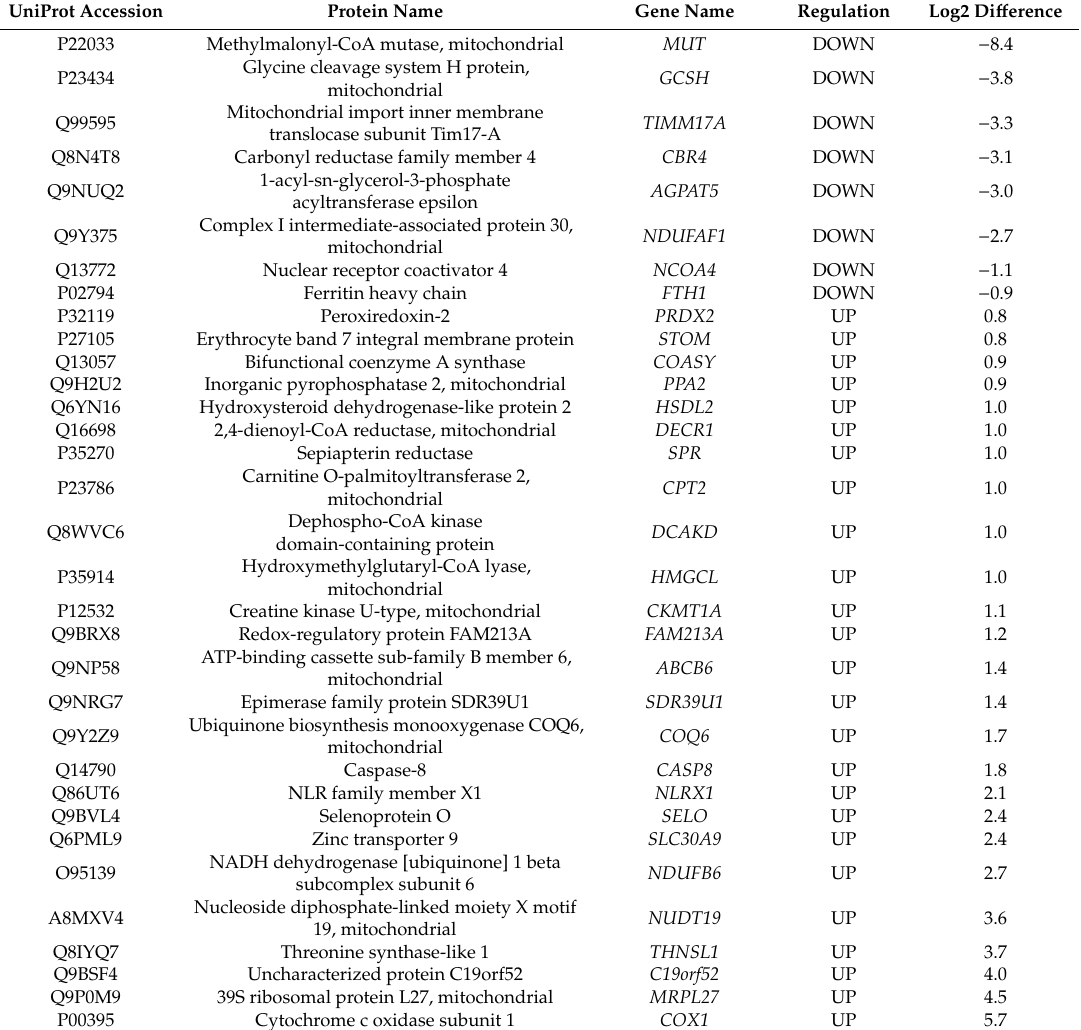
Table 2. Subset of dysregulated mitochondrial proteins identified by LFQ proteomics in MUT-KO. UniProt